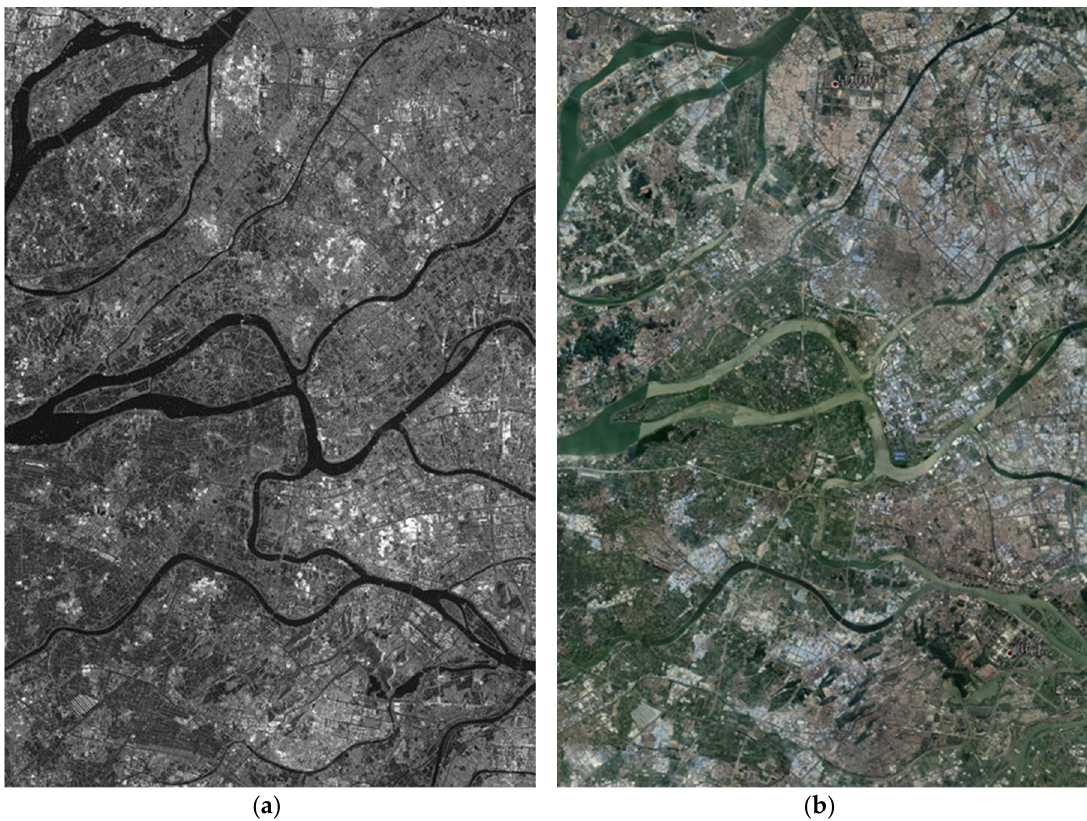
Figure 8. SAR image and the corresponding optical image of Foshan City. ( a ) SAR image; ( b ) corresponding optical image.